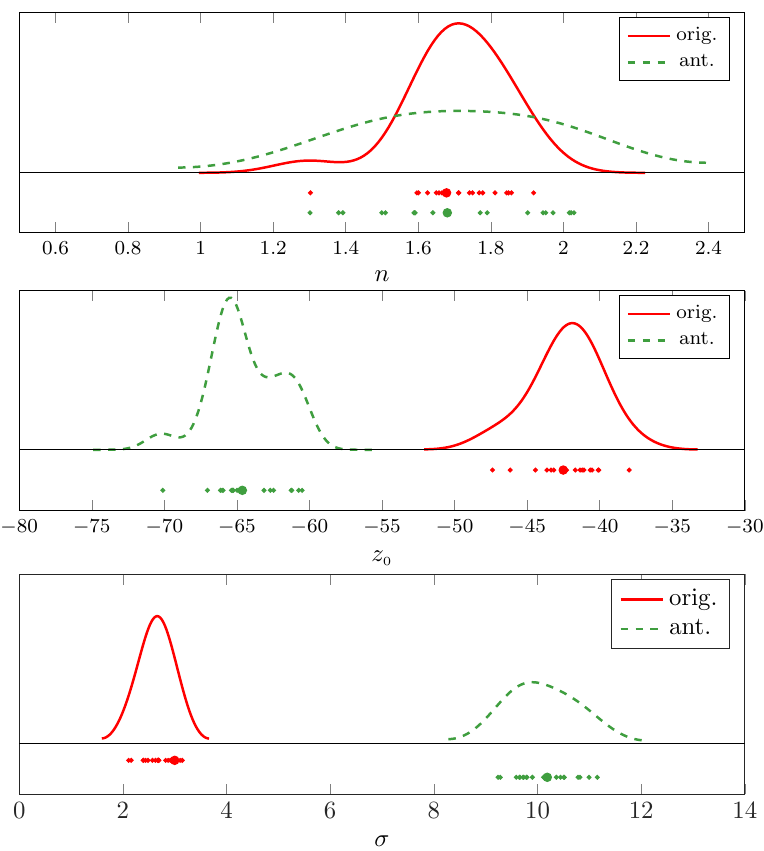
( b ) Example of the effect of a directional antenna ( κ = 1) on the parameters of individual models (IMs) (Orig. = original distribution, Ant. = distribution including the antenna effects). Data collected in one robot trajectory. d Figure 6. Examples of the effect of the antenna directivity in individual models (IMs). Data collected in the basketball